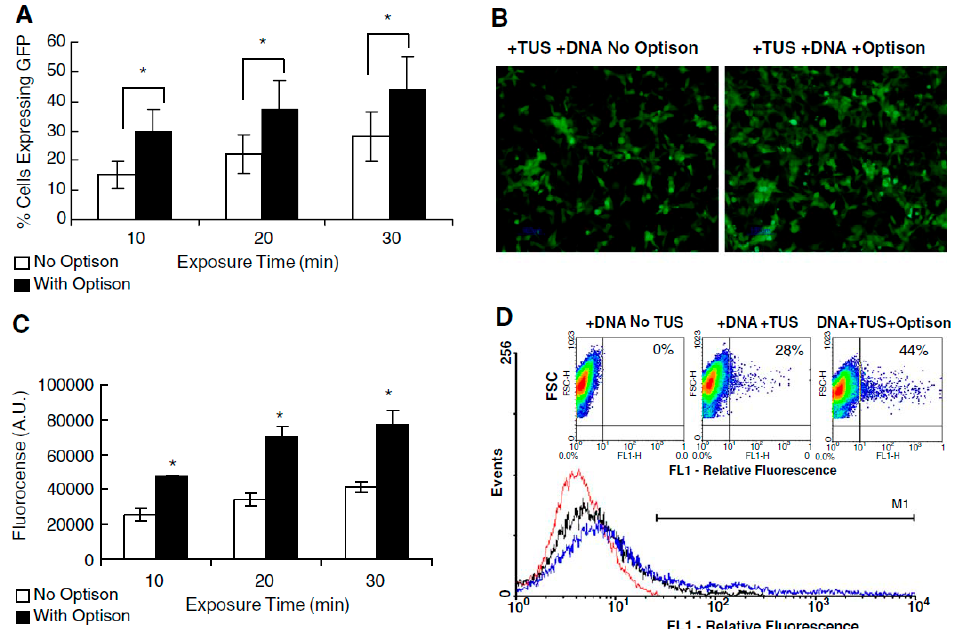
Figure 5. The effects of Optison ® on therapeutic ultrasound (TUS) transfection using pIRES-EGFP- BHK, a polymerase cellular promoters, cells were treated with 1 MHz TUS at 30% DC and 2 W/ cm (cid:2870) with or without Optison ® . ( A ) Effect of Optison ® ; ( B ) Fluorescent micrographs of cells expressing green fluorescent protein (GFP) 24 h post TUS transfection for 30 min with or without Optison ® . ( C ) Effects of Optison ® on total GFP expression post TUS. ( D ) Fluorescence-activated cell sorting (FACS) analysis of cells 24 h post TUS transfection for 30 min. FACS Dot-plot showing cell size (FSC) vs. green fluorescence (FL1) and percentage of the number of cells with fluorescence greater than the control * p < 0.05. Reproduced with permission from